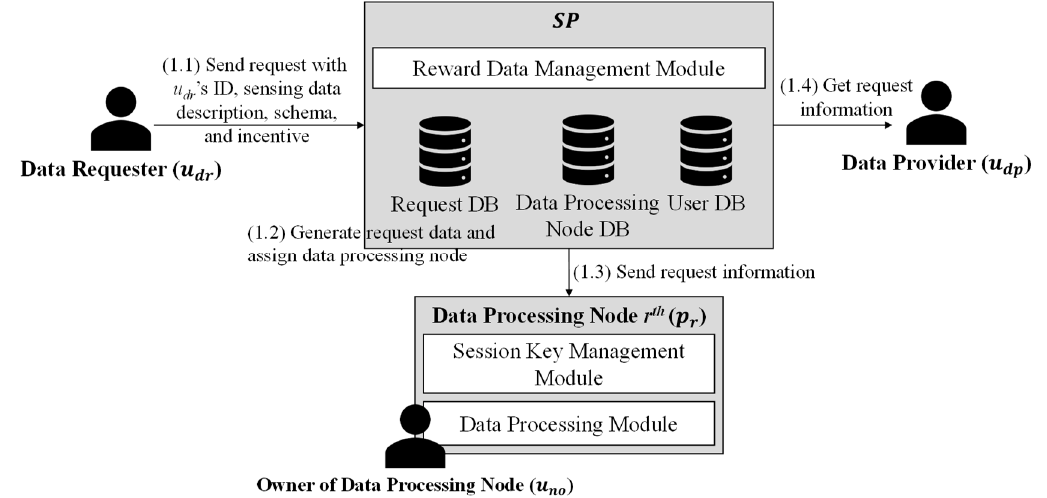
Figure 5. Flow of sensing data request.